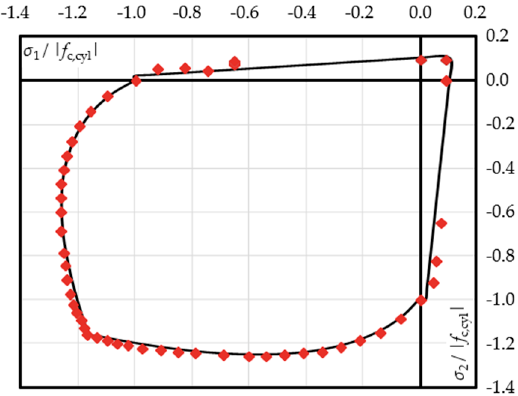
Figure 9. Numerical results compared to the strength envelope, according to Kupfer et al. [41].